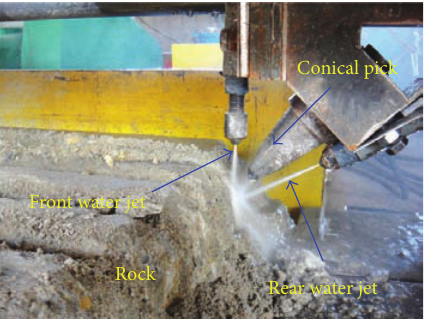
Figure 14: Photo of cutting experiment for JFRP.